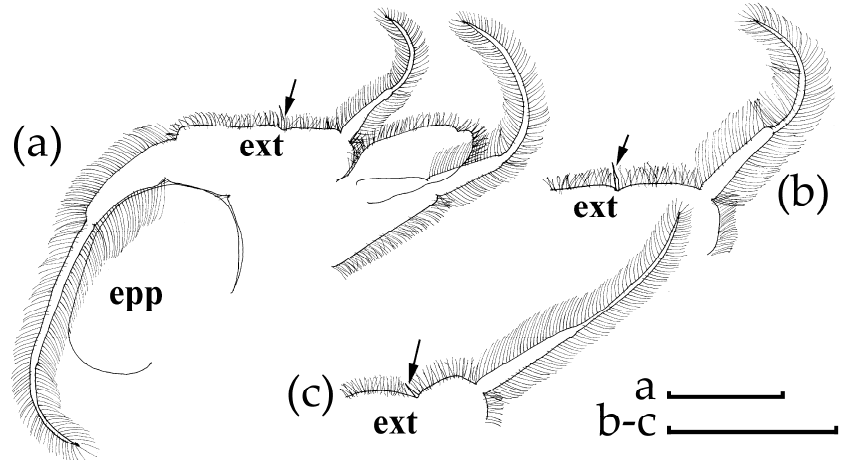
Figure 11. Limb V in D. ( C. ) sinensis group. ( a , b ) Thoracic limb V of adult female of Daphnia inopinata Popova et al., 2016 from Munchen Siger, Germany (type locality); ( c ) Thoracic limb V of adult female of Daphnia similoides Hudec, 1991 from Ooty Lake in Nilgiris Mountains, Tamil Nadu, India (type locality). All scale bars are 0.1 mm.